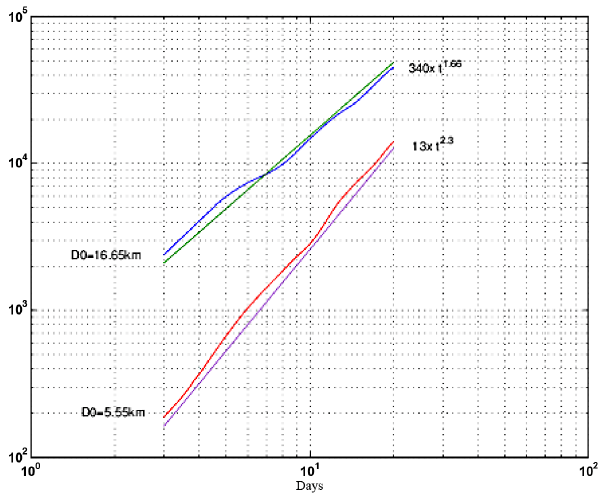
Fig. 5c. Zonal relative dispersion D 2 x in the second phase (3< t <20days) for D 0 = 5 . 55km (red curve) and D 0 = 16 . 65km (blue curve). The two curves are fitted respectively by 13 t 2 . 3 (pur- ple curve) and 340 t 1 . 66 (green curve).